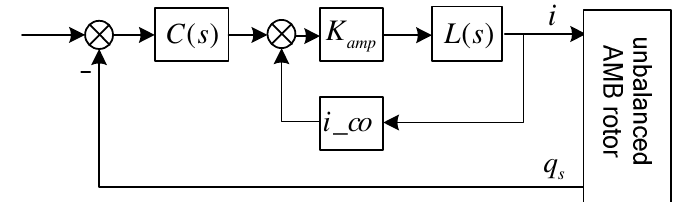
Figure 7. The control block diagram of the MLR system.